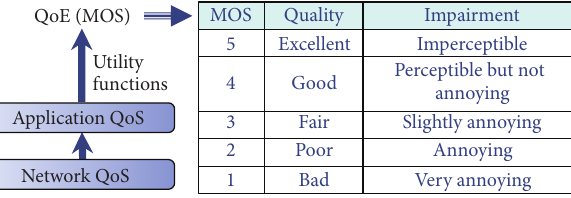
F 3: Bottom-up approach to evaluate the